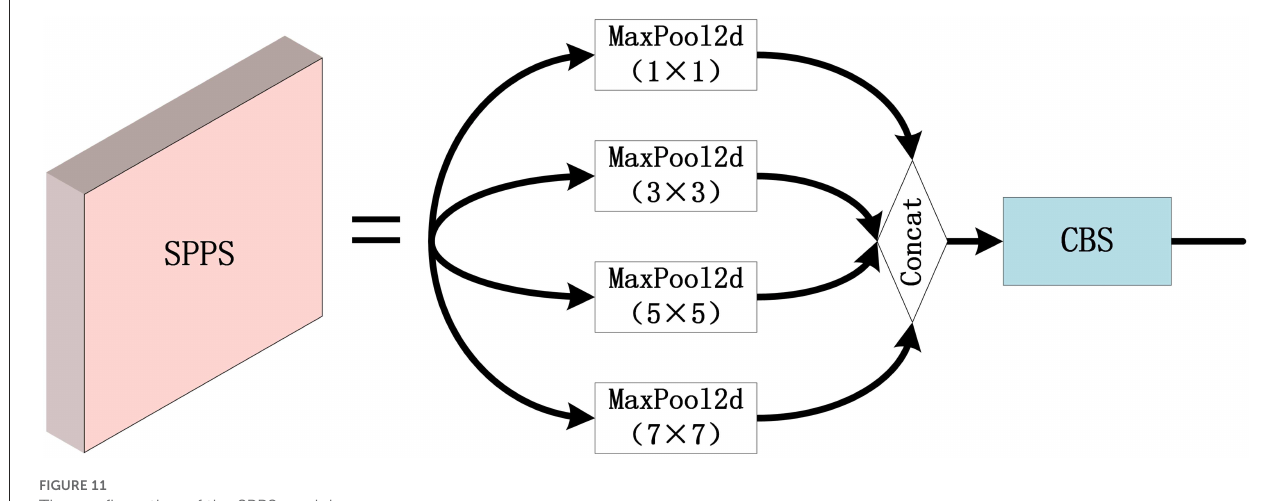
FIGURE11 The configuration of the SPPS